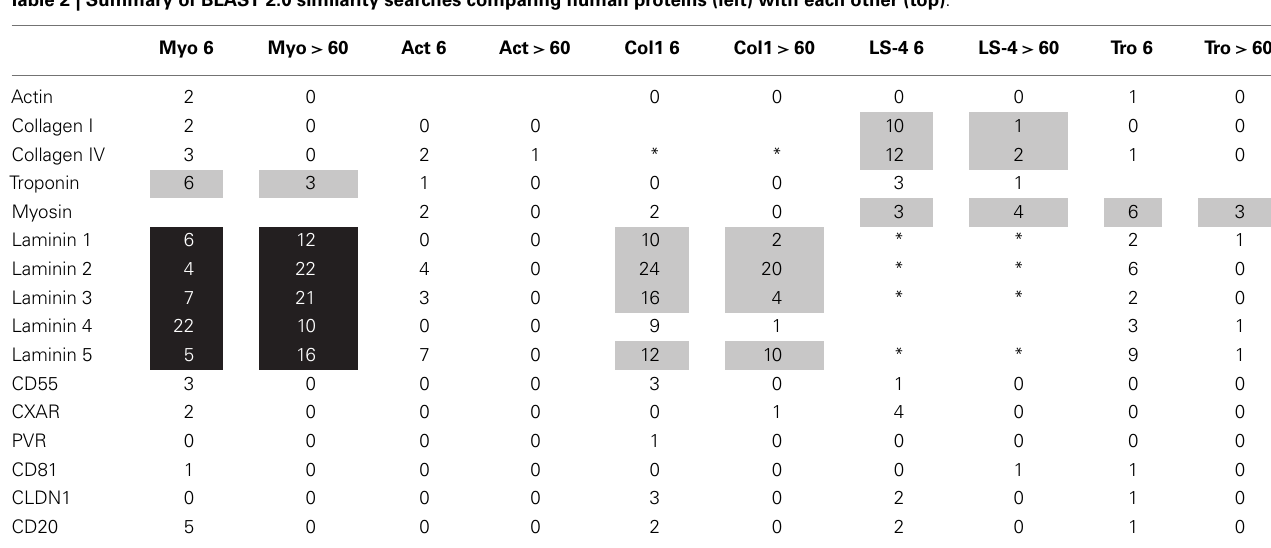
Table 2 | Summary of BLAST 2.0 similarity searches comparing human proteins (left) with each other (top)